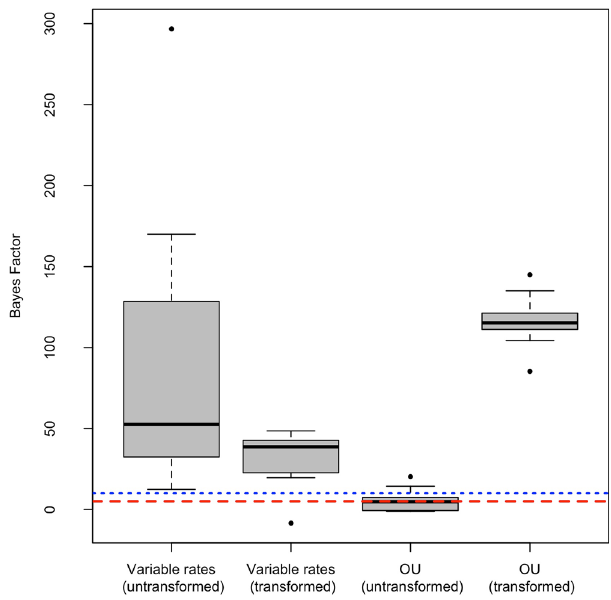
Fig. 3 Demonstrating the effects of log transformations on support for the variable rates and OU models using random data. Centre lines of each series indicate the median; boxes in grey show upper and lower quartiles. Whiskers indicate interquartile ranges, with points indicating outliers. Moderate support, indicated by a Bayes factor of 5 or more, is indicated by the red dashed line. Strong support, indicated by a Bayes factor of 10 or more, is indicated by the blue dotted line. This demonstrates that log transformation can inherently suppress support for variable rate models, and promote support for OU